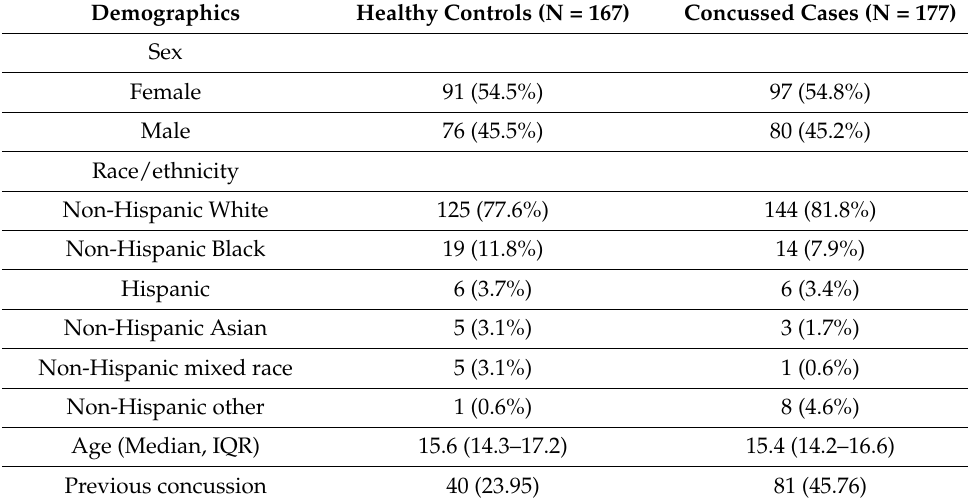
Table 3. Demographic and clinical characteristics of the study